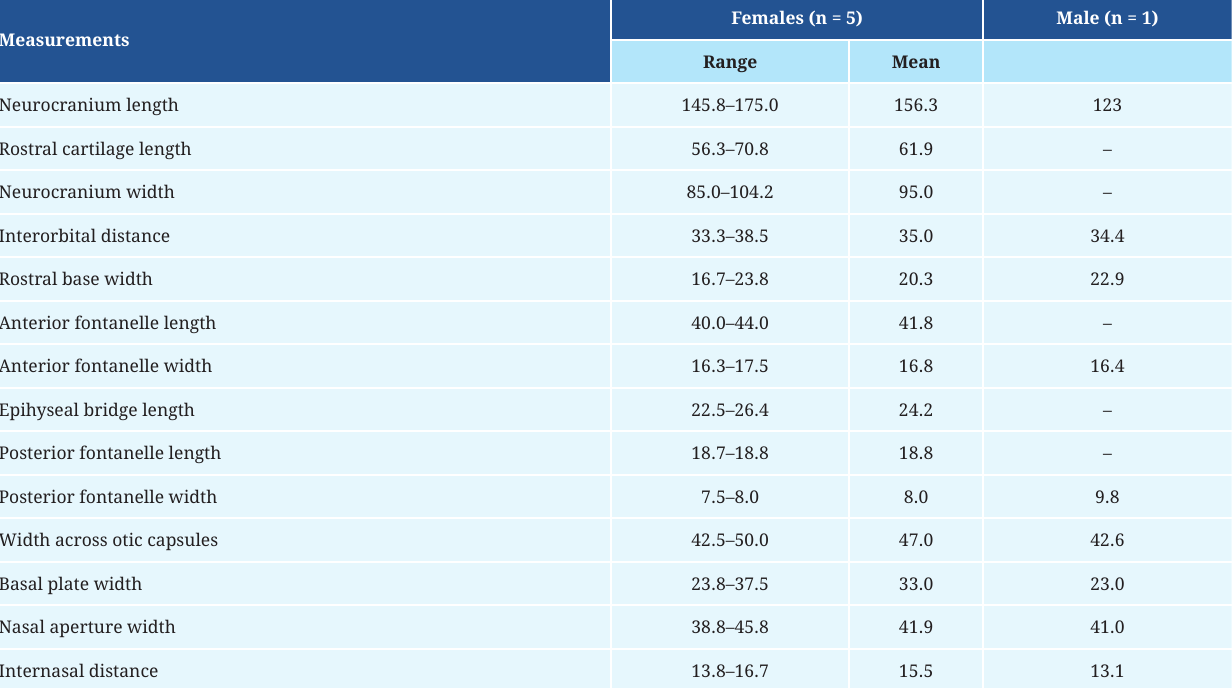
TABLE 3 | Neurocranial measurements in percentages of nasobasal length (% NL) of male and female specimens of Atlantoraja castelnaui .